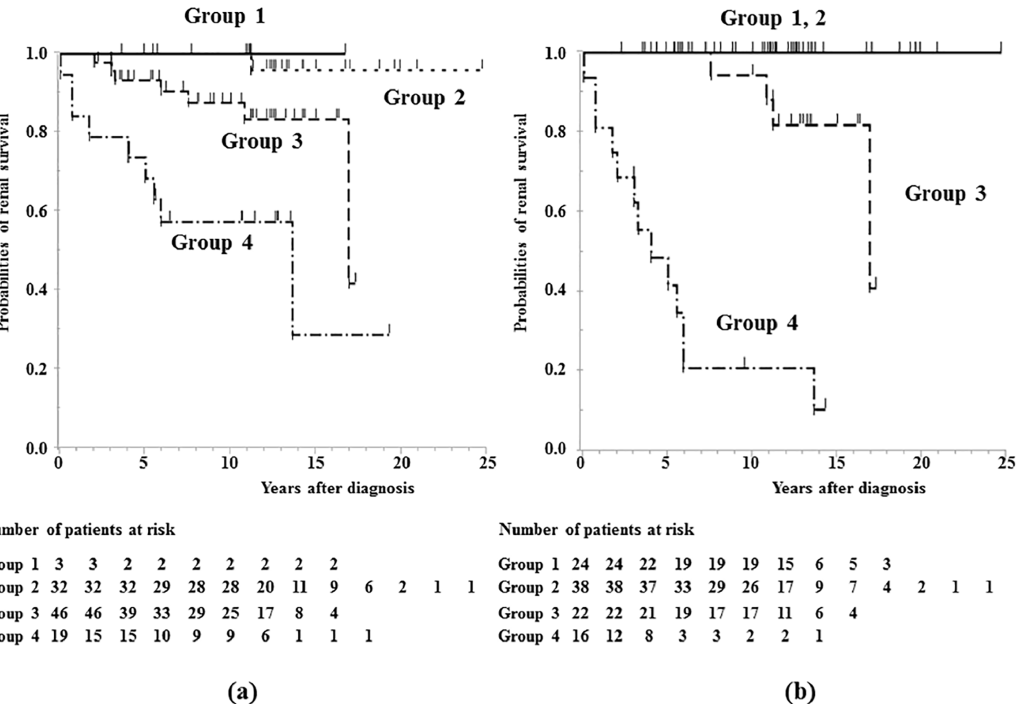
Fig 3. Survival curve showing time to CRI. a) Kaplan-Meier plot showing time to CRI stratified by proteinuria at diagnosis. b) Kaplan-Meier plot showing time to CRI stratified by proteinuria during follow-up period. group 1, no proteinuria ( < 0.2 g/day/1.73 m 2 ); group 2, mild proteinuria (0.2 – 1.0 g/day/1.73 m 2 ); group 3, heavy proteinuria without hypoalbuminemia ( > 1.0 g/day/1.73 m 2 with serum albumin level (cid:1) 3.0 g/dL); group 4, heavy proteinuria with hypoalbuminemia ( > 1.0 g/day/1.73 m 2 with serum albumin level < 3.0 g/dL).